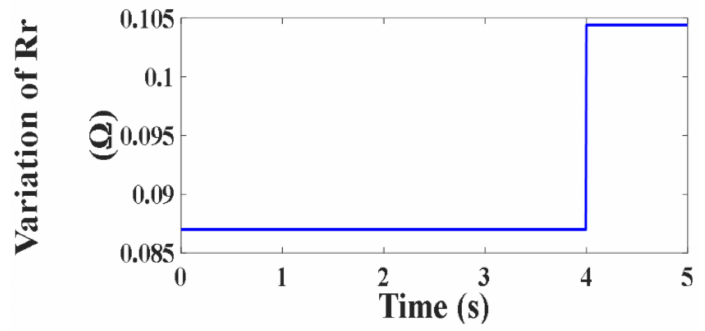
Figure 138. Variation of R r ( Ω